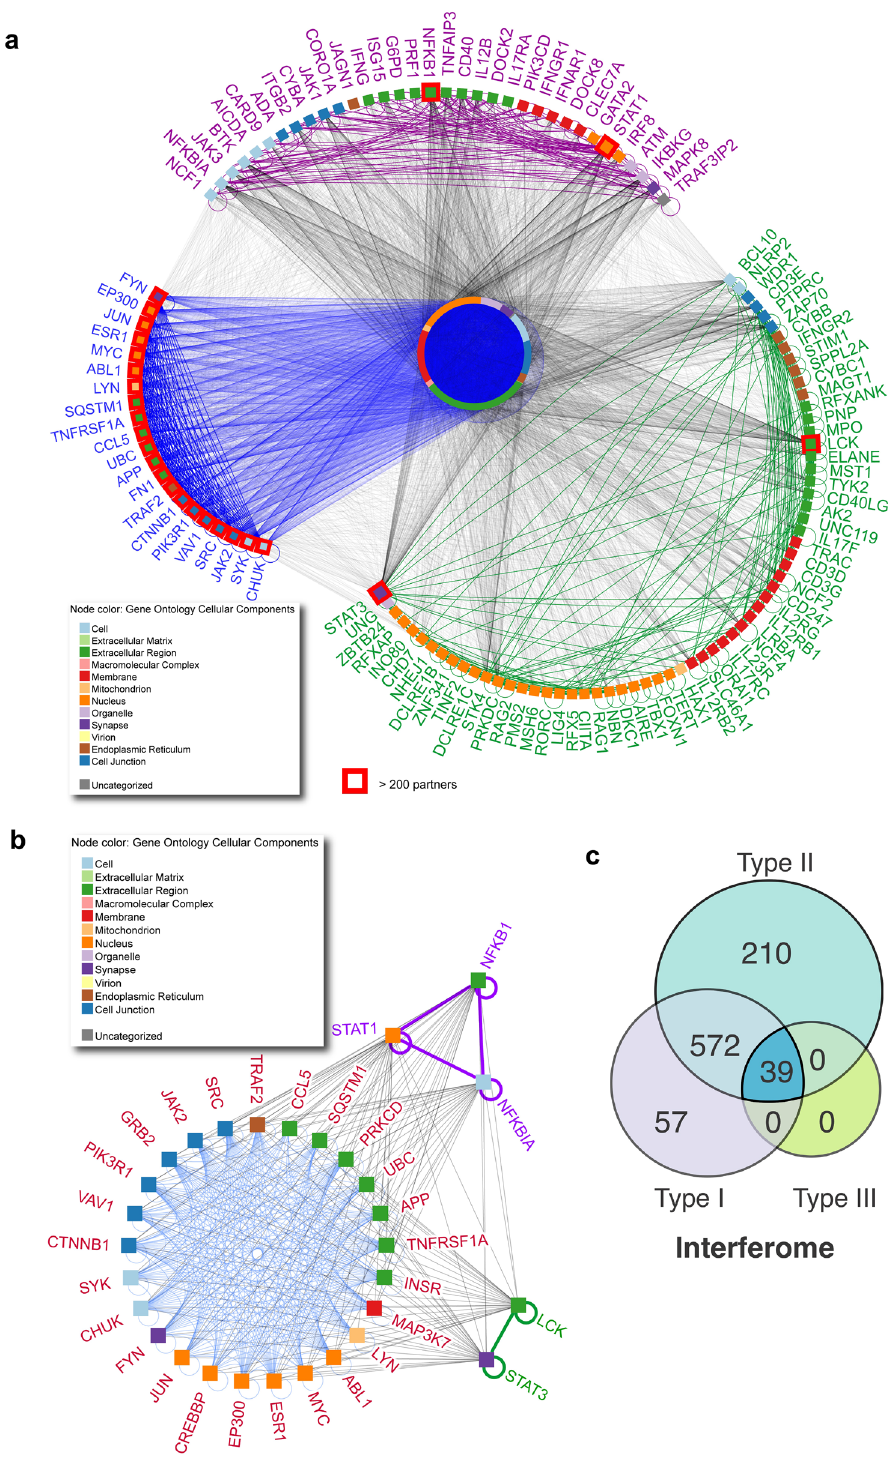
Figure 6. The interactome of DEGs enriched in signaling pathways involved in the anti- Candida immune response and its association with inborn errors of immunity. ( a ), Relationships (edges) among the 1096 DEGs (nodes) found across all studies (Suppl. Table S11). Subnetworks (semicircles) represent genes associated with IEI causing increased susceptibility to candidiasis; 34 purple node genes are shared with the group of 1096 DEGs, and 66 green nodes represent those not found in the Candida datasets. Blue nodes are highlighted genes with more than 200 partners of interaction. Colored squares and circles represent the cell location of genes. The interaction network was built using NAViGaTOR software. ( b ), Network of hubs present in ( a ). ( c ), Proportional Venn diagram (created using CorelDraw2019, available at coreldraw.com) of interferon types associated with the group of 1096 DEGs. Interferome analysis revealed 878 IFN-regulated genes modulated by IFN types I, II, and III, as shown in the Venn diagram. DEGs, differentially expressed genes; IFN, Interferon; IEIs, inborn errors of immunity; TLR, Toll-like